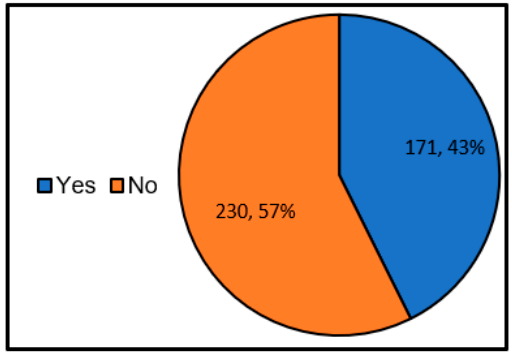
Figure 9. Presence or absence of participation of facility managers, who are the shelter operating entities.